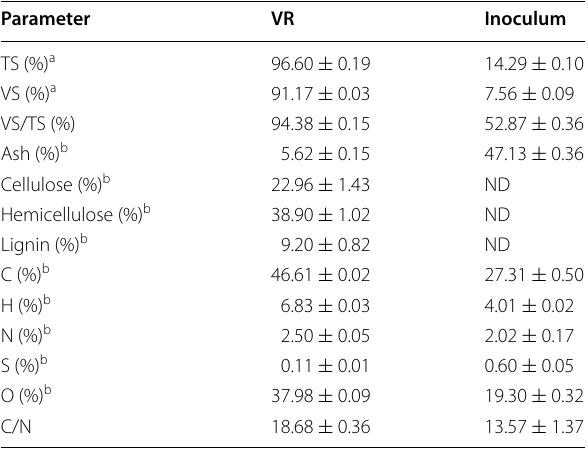
Table 1 Characteristics of VR and